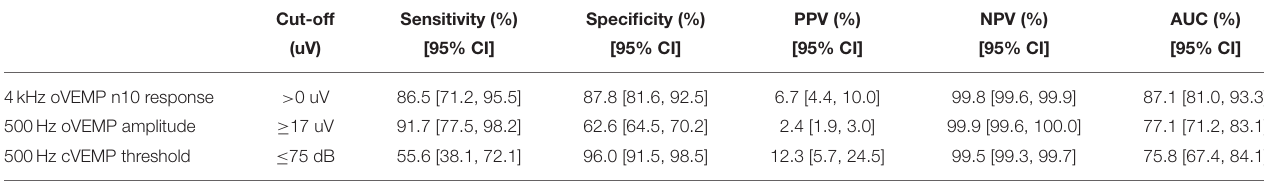
TABLE 3 | VEMP sensitivity and specificity for diagnosis of SCD θ .